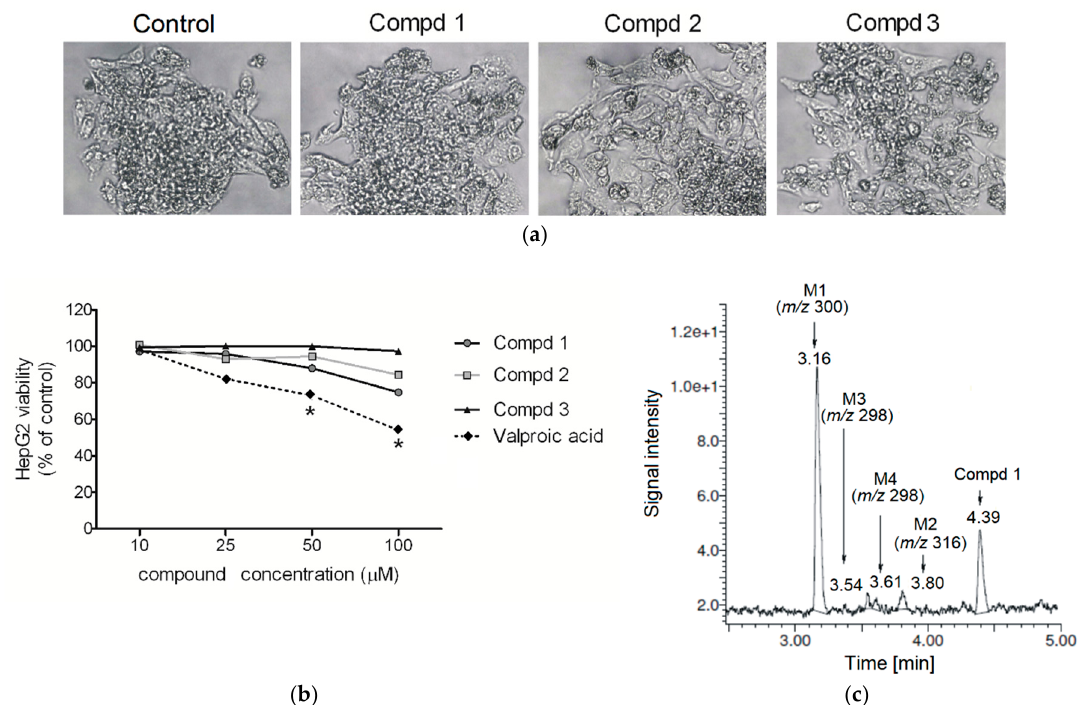
Figure 4. Hepatotoxicity of 1 , 2 , and 3 . Cells were cultured in medium supplemented with 10% FBS in the absence or presence of compounds (10, 25, 50, or 100 µM). After 24 h incubation, pictures of cells were taken using bright field microscope ( a ) and the MTT assay ( b ) was performed. Results from the MTT assay show the percent of living (metabolically active) cells. Values represent means ± SEM of three independent experiments ( p < 0.05). Valproic acid was used as positive control. Metabolic activation and trapping assay ( c ); representative chromatogram of 1 and its metabolites following incubation of 1 with human liver microsomes supplemented with NADPH and reduced glutathione. Molecular masses of the [M + H] + ions of metabolites are shown.